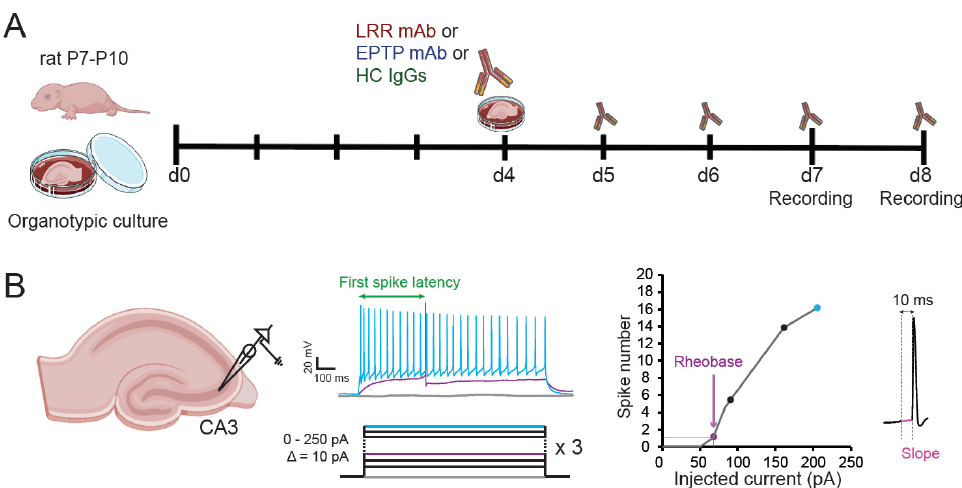
Figure 1. Experimental procedures. ( A ) Timeline representing the patient-derived mAb incubation protocol. Hippocampal slices of rat aged of 7 to 10 post-natal days (P7-P10) were put in culture and individually incubated with either a recombinant LRR-mAb, a recombinant EPTP-mAb, or polyclonal IgGs from healthy human patient (HC IgGs) at 4 days of culture until the days of experiment at day 7 (d7) and day 8 (d8). ( B ) CA3 pyramidal neurons from organotypic cultures treated with the different antibodies were recorded in current-clamp mode. The number of spikes elicited by the injection of depolarizing currents with increments of 10 pA from 0 to 200 pA was measured to obtain an input–output curve. The minimal current injected to elicit at least an action potential (rheobase) was determined. The slope of the membrane potential trajectory before the action potential was quantified in a time window of 10 ms.